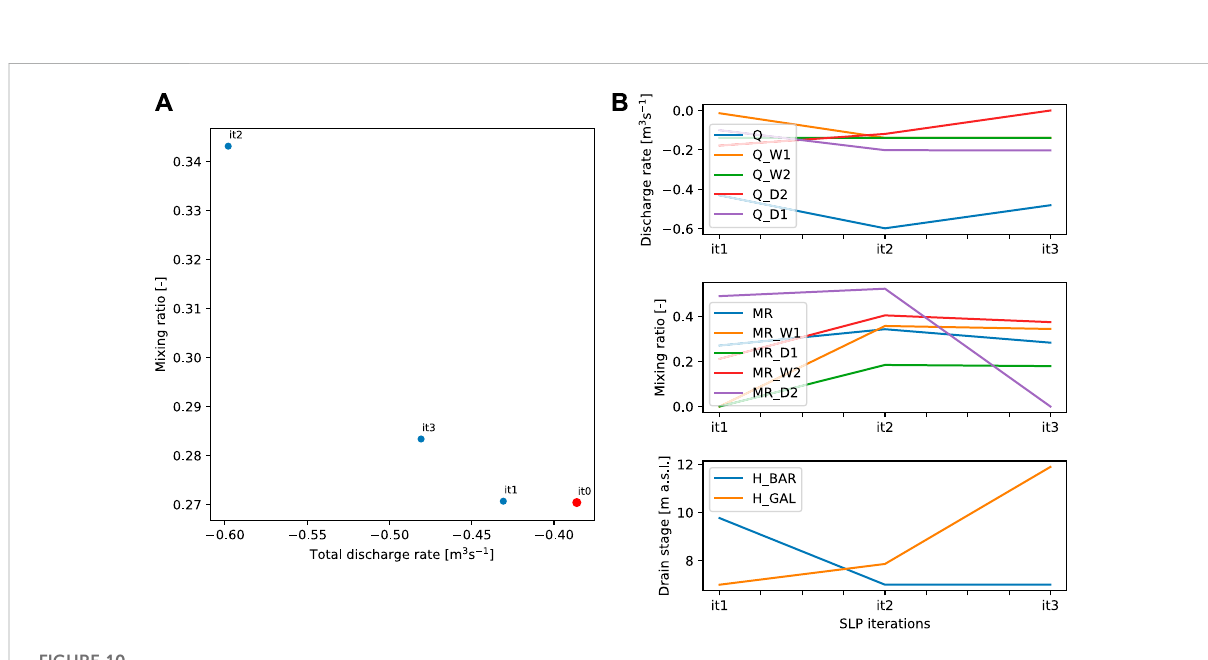
FIGURE 10 Optimization results with (A) total discharge rate and mixing ratio for each optimization iteration of PESTPP-OPT and (B) discharge rate (Q), mixing ratio (MR), and drain stage (H) for each optimization iteration. it0 represents the initial parameter values, it1, it2 and it3 the values for the fi rst, second and third iterations,